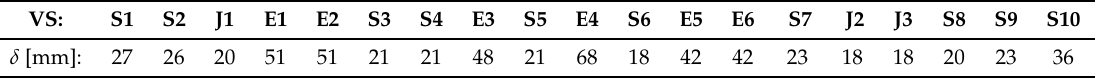
Table 2. Uncertainties δ of the adjusted virtual station (VS) elevations in